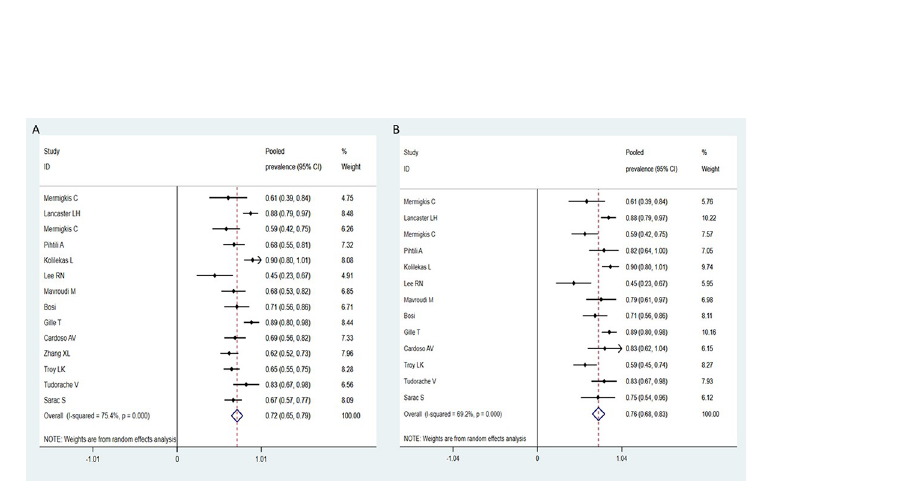
Fig 2. Funnel plot of the prevalence of OSA in DPLD patients (A) and in IPF patients (B).